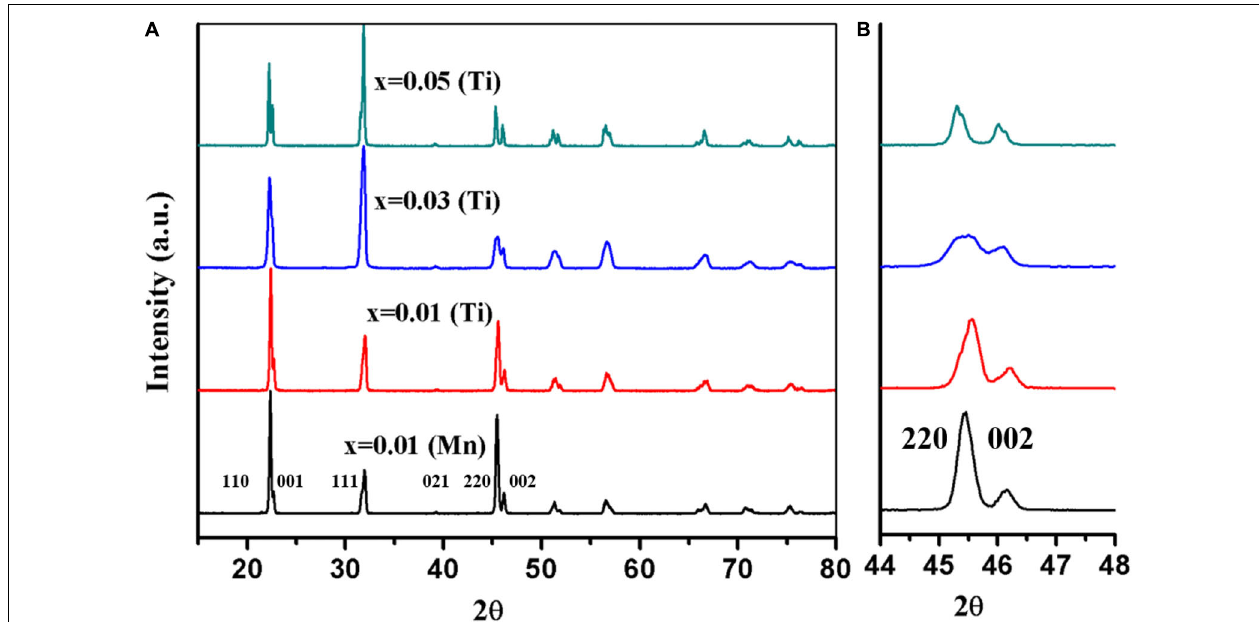
FIGURE 1 | (A) Single phase XRD patterns of Mn- and Ti-doped KNN-50/50, (B) zoomed peaks at 2 θ ∼ 45–46.